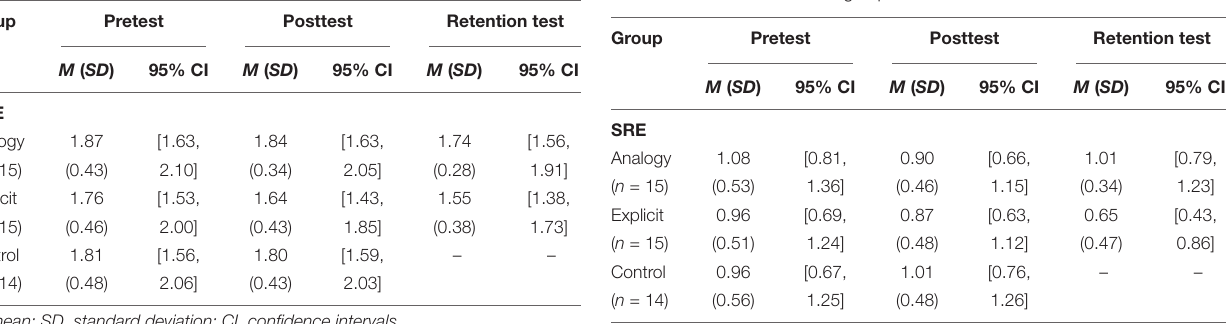
TABLE 2 | Descriptive statistics for MRE in meters across the pretest, posttest, and retention test for the three groups.